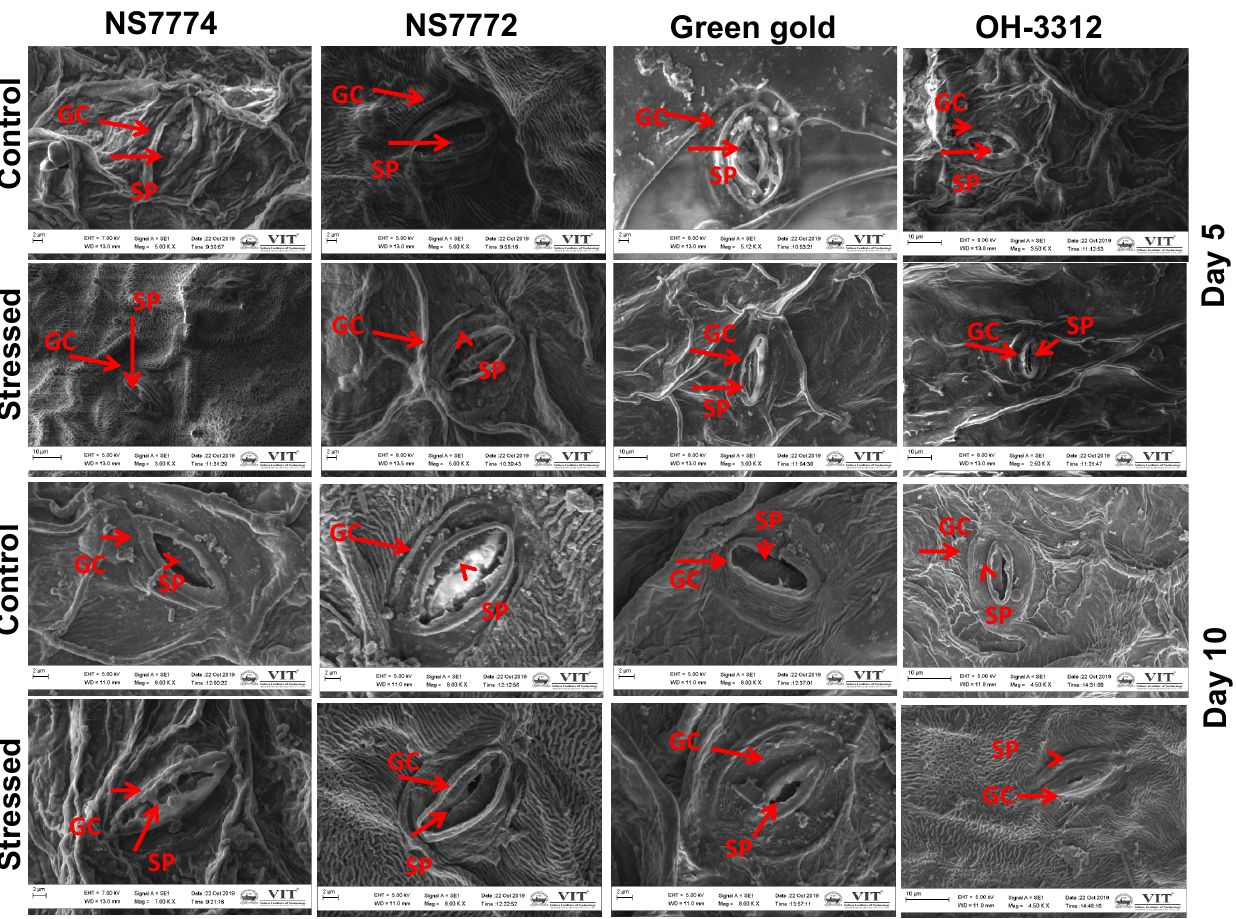
Figure 10. Representative images of stomata, as affected by drought stress at 5 and 10 days of interval in okra genotypes NS7774, NS7772, Green Gold, and OH3312, along with respective controls observed under scanning electron microscope (SEM) at 40X magnification. In images, GC indicates guard cells and SP indicates stomatal pore.